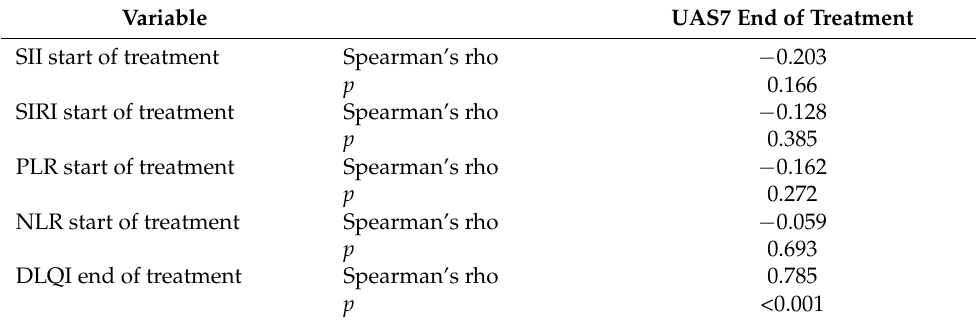
Table 4. Correlation of selected variables.